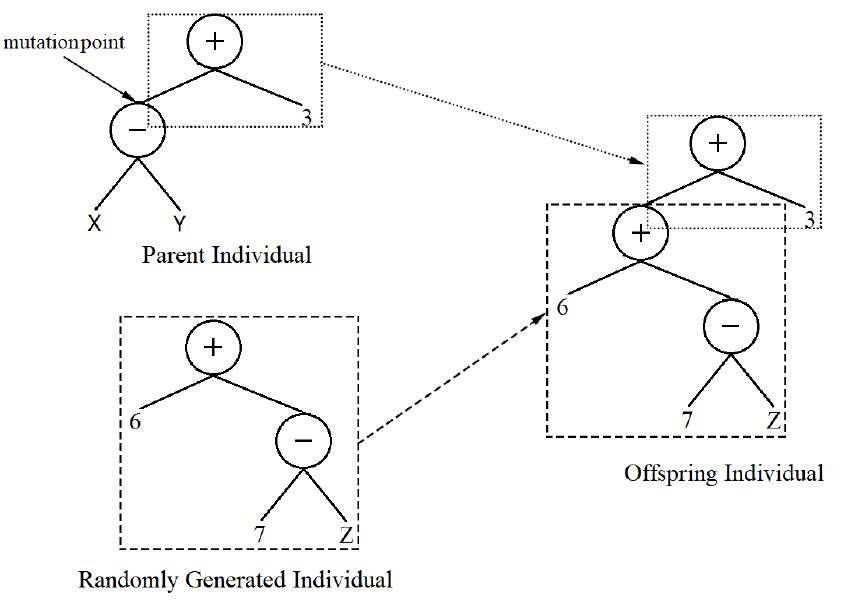
Figure 7. The mutation process of in the individual tree ( X − Y ) +